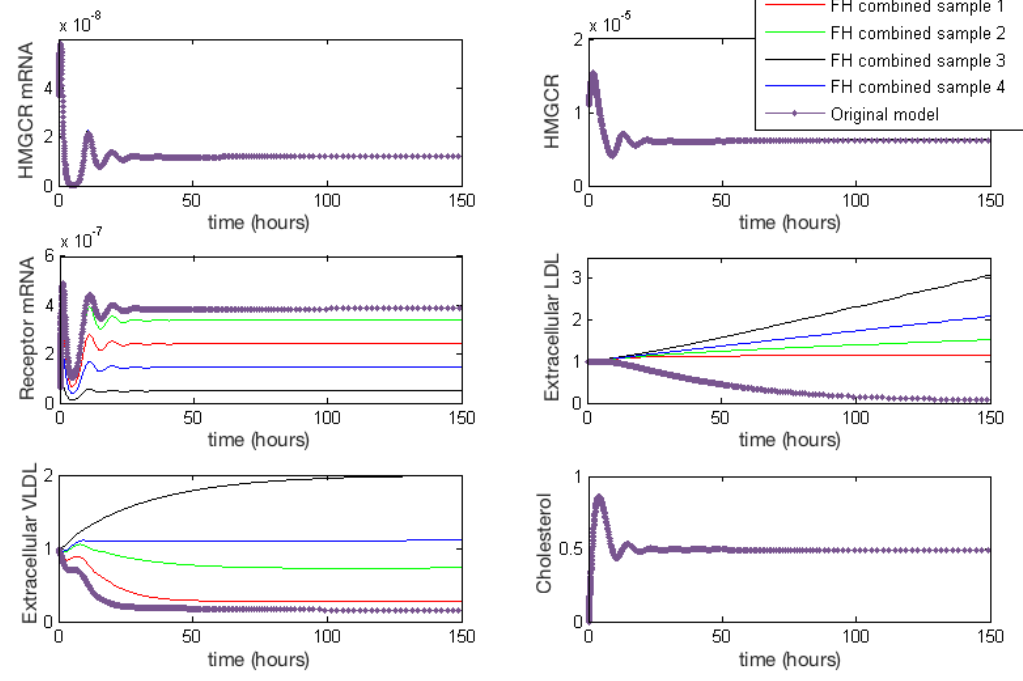
Figure 4. Familial Hypercholesterolaemia combined effects on HMGCR mRNA, HMGCR, LDLR mRNA, extracellular LDL and VLDL and cellular cholesterol levels. Results for all model variables are given in Appendix